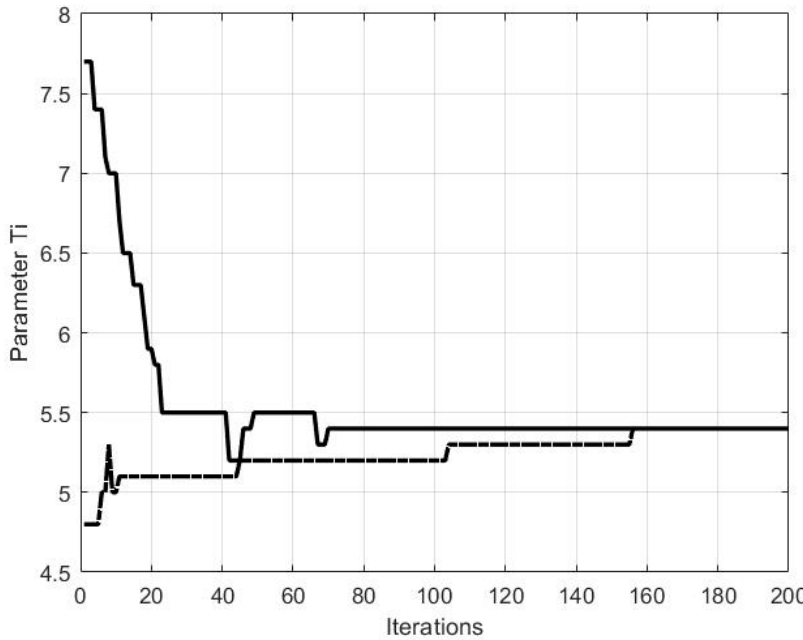
Figure 6. Example of convergence of parameter Ti, for a PT2 system and ITAE criterion with a controller output limitation of +/ − 5. The initial random values 7.7 and 4.8 represent the two lines and converge both to the end value 5.4